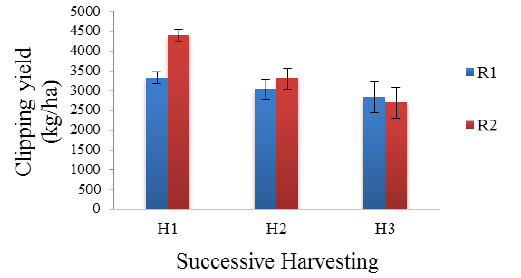
Fig. 1. Effect of fertilizer rate (R) and successive harvesting